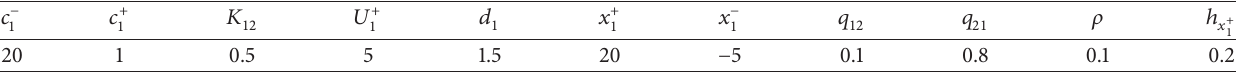
Table 1: Data parameters.